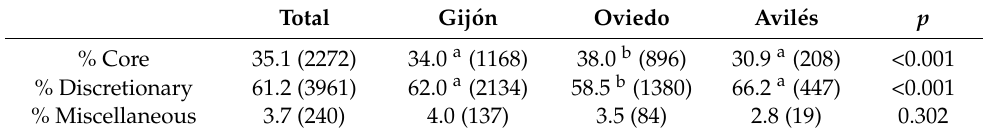
Table 1. Percentage of major categories products advertised around the schools, classified by city.